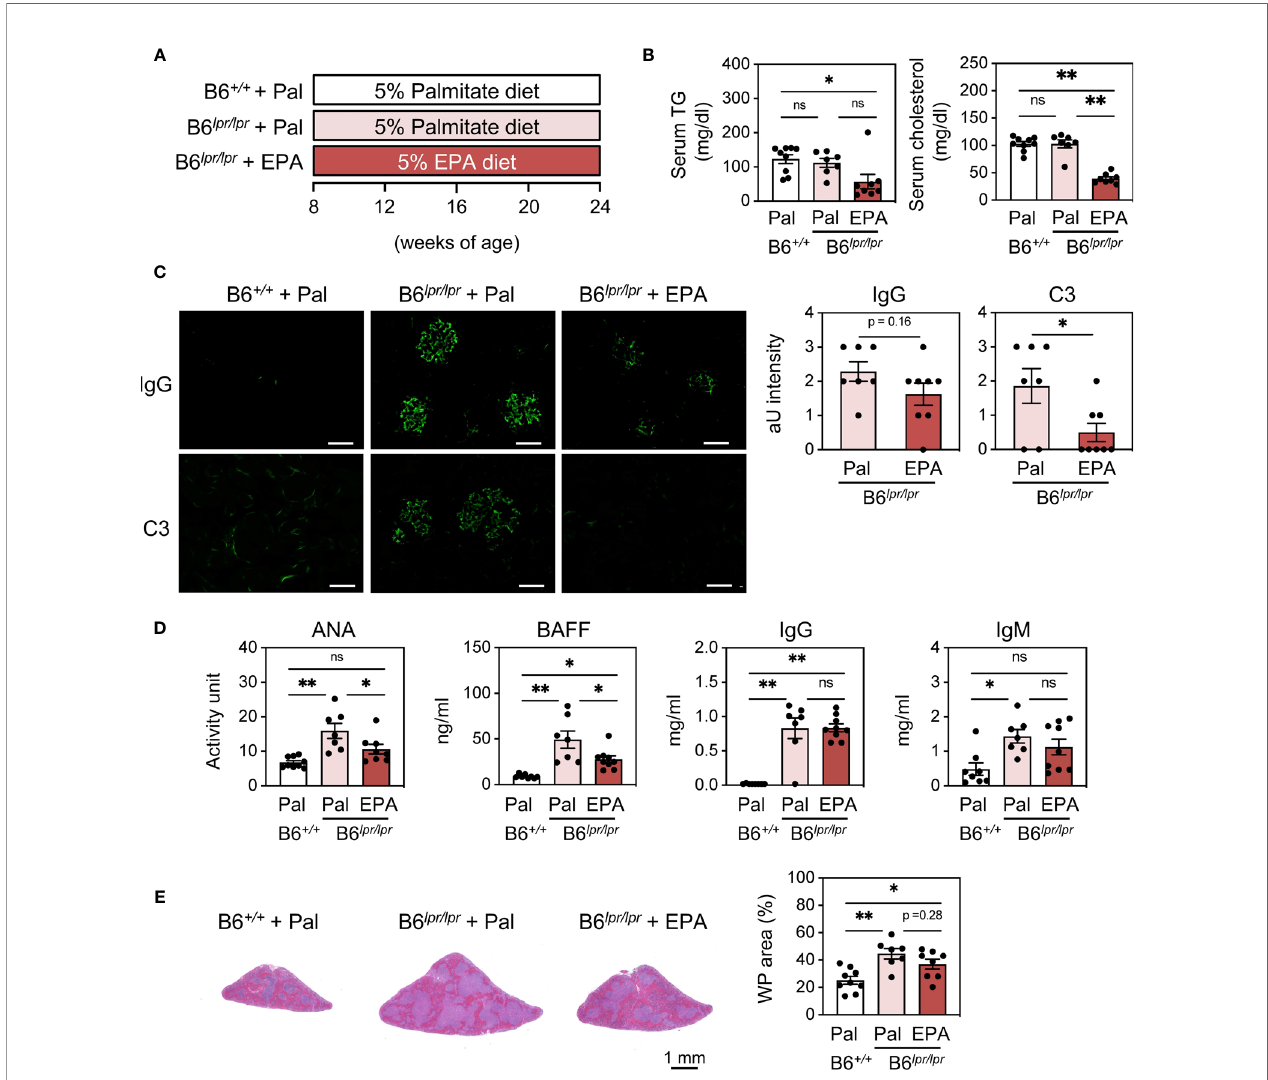
FIGURE 3 | EPA supplementation ameliorates autoimmunity in C57BL/6J lpr/lpr spontaneous lupus mice. (A) Experimental protocol. Eight week-old control C57BL/ 6J +/+ and C57BL/6J lpr/lpr mice were fed CE-2 diet supplemented with 5% ( wt/wt ) Pal or EPA for 16 weeks. (B) Serum TG and total cholesterol levels. (C) Immunostaining of FITC-labeled anti-mouse IgG or C3 in kidney (left) and quanti fi cation of IgG and C3 deposition (right). Original magni fi cation: × 400, Scale bars represent 50 m m. (D) Serum levels of ANA, B cell activating factor (BAFF), total IgG and IgM. (E) H&E staining of spleen sections (left) and quanti fi cation of WP area in whole spleen area (right). B6 +/+ + Pal, n = 9; B6 lpr/lpr + Pal, n = 7; B6 lpr/lpr + EPA, n = 8. Data shown are mean value ± SEM of representative experiments at least twice independently. Statistical analysis was performed with Dunn ’ s test ( B, D : IgG) or Tukey ’ s test (if not otherwise stated). *p < 0.05; **p < 0.01; ns, not signi fi cant. See also Figure S4